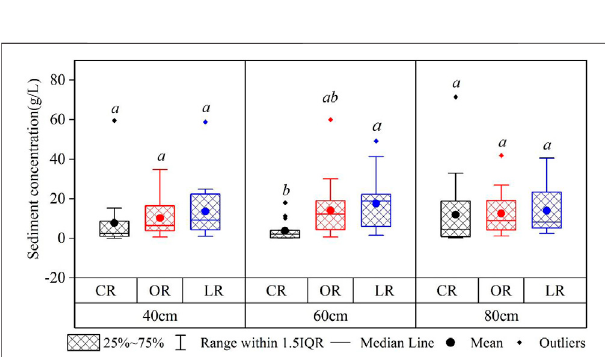
FIGURE 6 | Runoff sediment concentration under CR, LR, and OR and three ridge widths, boxes labeled with different letters within groups indicate signi fi cant differences at p < 0.05. CR, OR, and LR represent cross-ridge tillage, oblique-ridge tillage, and longitudinal-ridge tillage, respectively. 40, 60, and 80 cm represent 40 cm ridge width, 60 cm ridge width, and 80 cm ridge width, respectively.